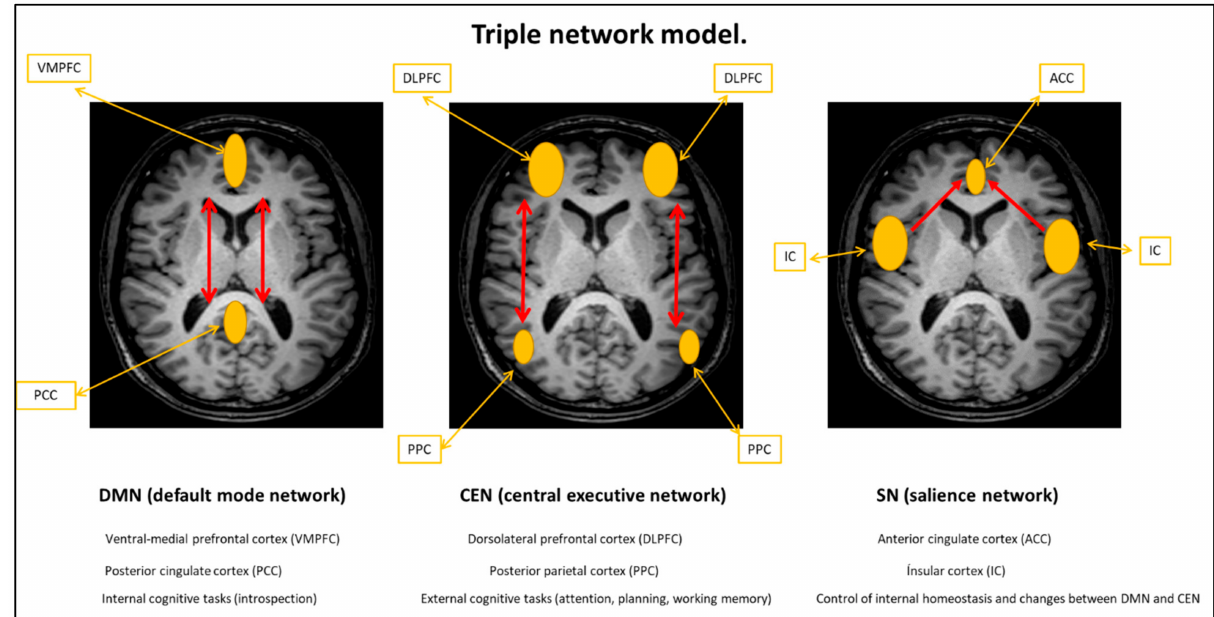
Figure 1. Graphic illustration of the triple network model for cognitive control proposed by Menon composed of the “Default Motor Network” (DMN), the “Salience Network” (SN), and the “Central Executive network” (CEN). According to this model, the anterior insula (belonging to the executive network) plays a key role since it activates CEN and deactivates DMN in response to outgoing stimuli to perform tasks of attention, planning, and working